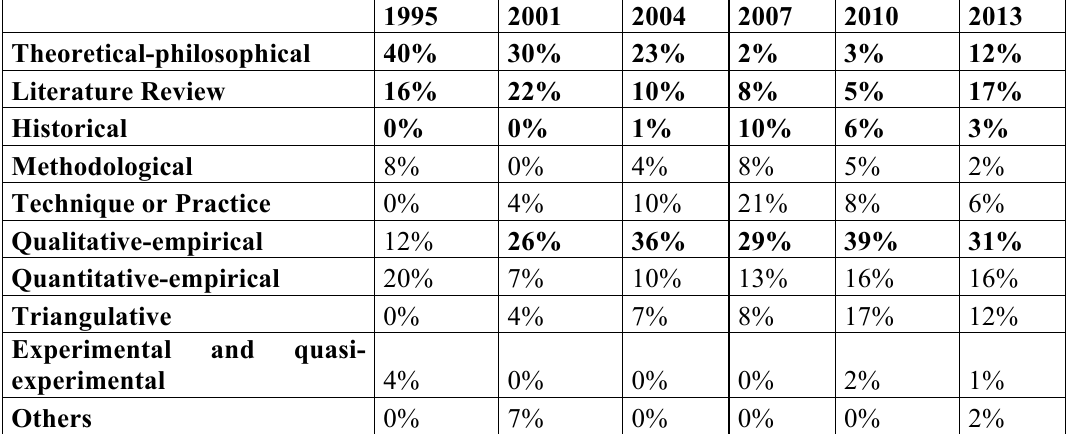
Table 4: ESREA conferences and the methods applied in